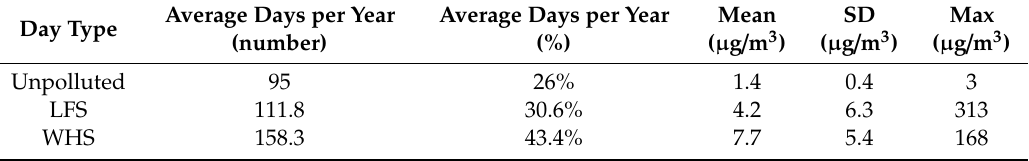
Table 2. Average number of days per year (total and %) and 24-h PM 2.5 summary statistics by day type.